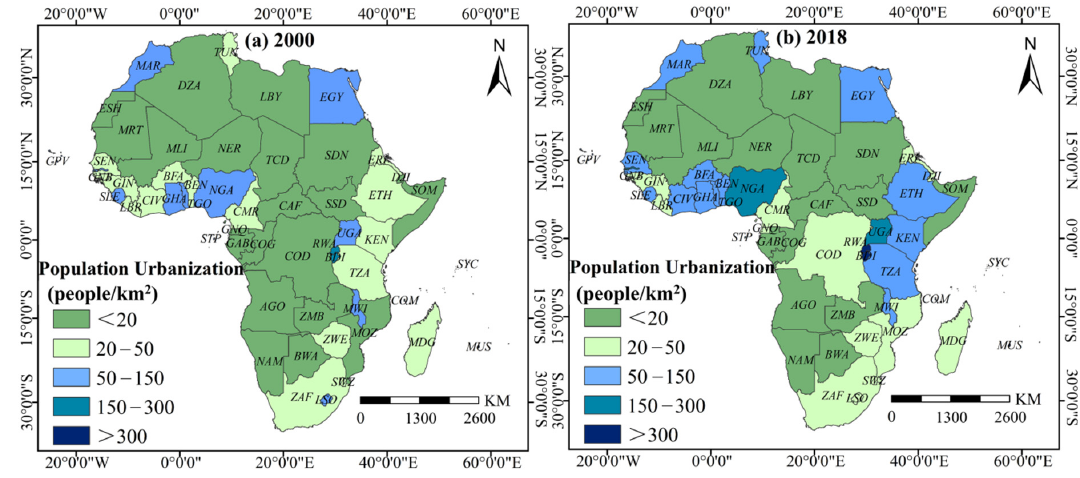
Figure 4. Spatial pattern of population urbanization level in African countries in 2000 and 2018.